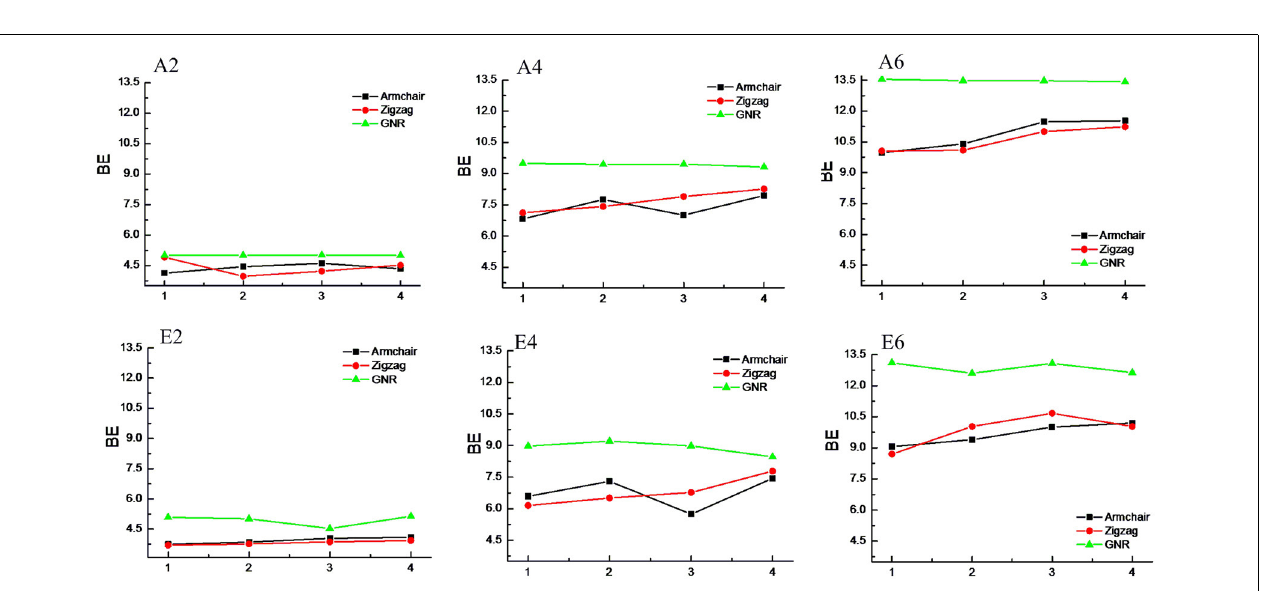
FIGURE 8 | Effect of curvature and chirality on the binding affinity of acyclic hydrocarbons with CNSs.